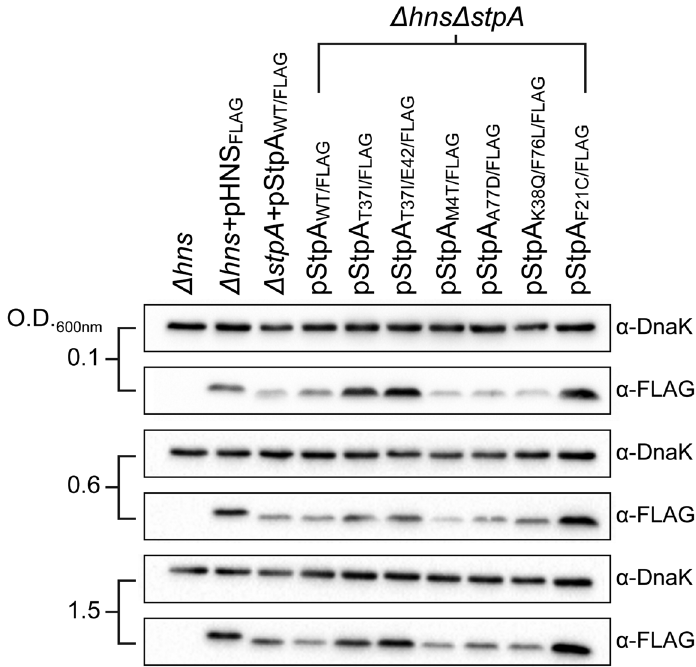
Figure 6. StpA missense mutations do not affect intracellular protein concentrations. Expression levels of FLAG-tagged StpA variants were monitored by western blot analysis at early exponential phase (O.D. 600 nm 0.1) mid exponential phase (O.D. 600 nm 0.6) and early stationary phase (O.D. 600 nm 1.5). a -DnaK served as a loading control.